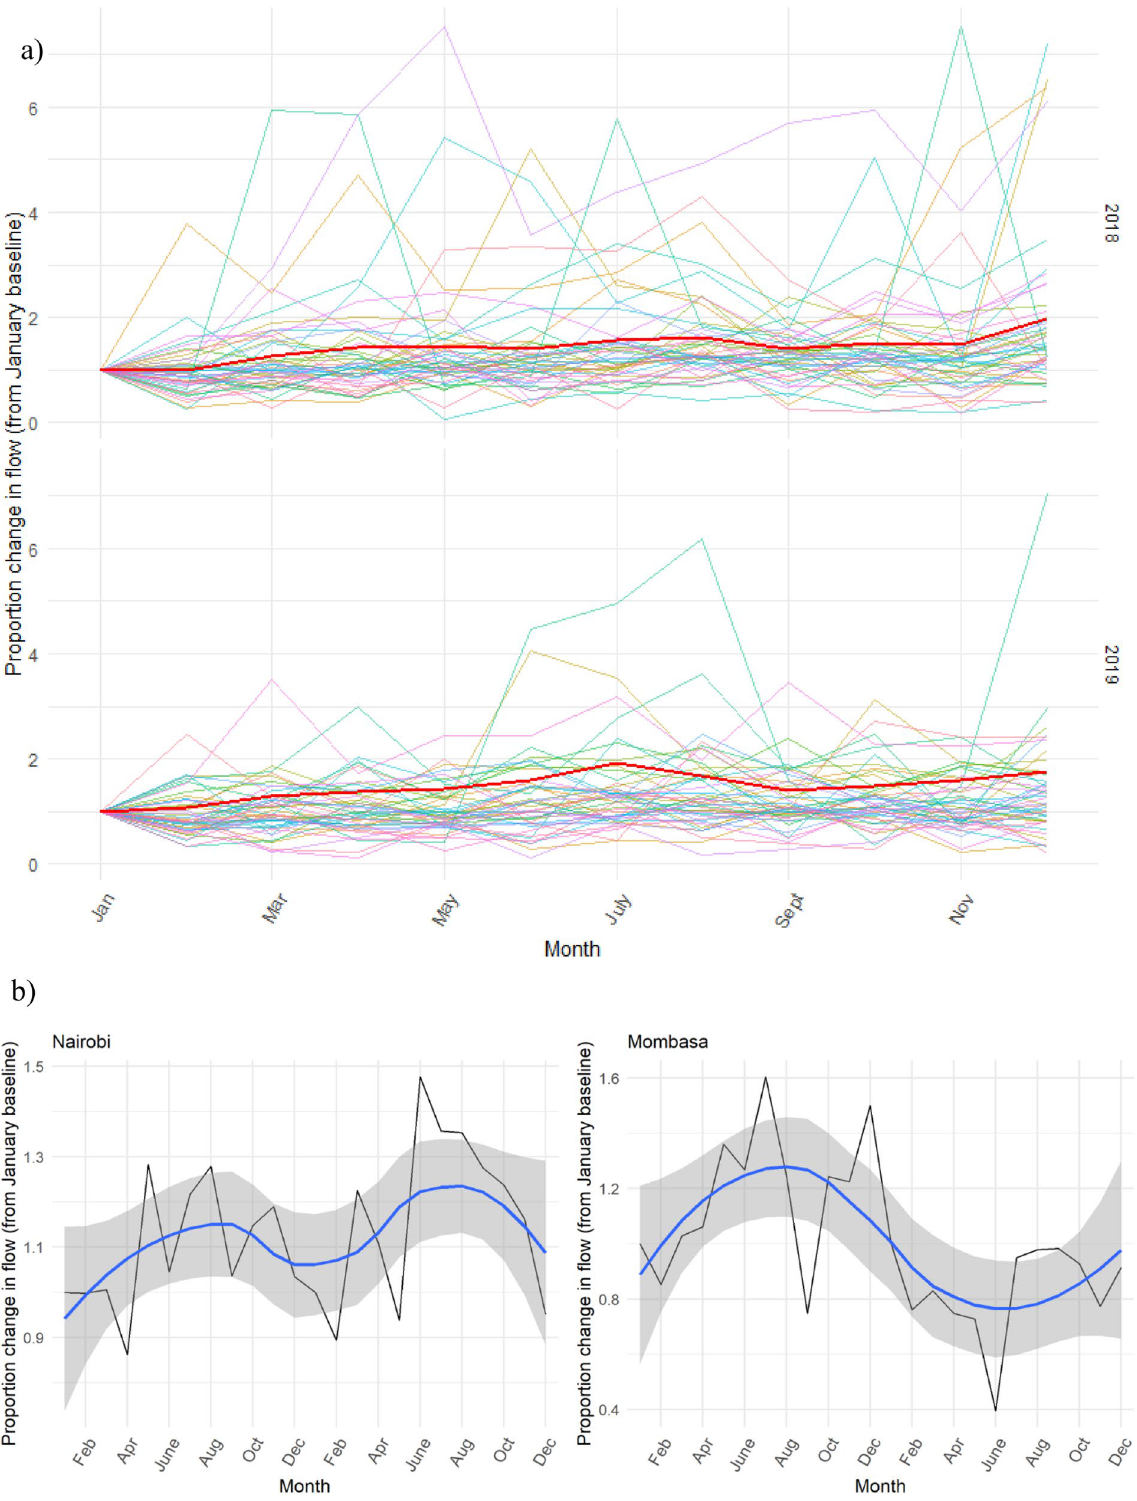
Figure 2. ( a ) Observed change in monthly population flows for 2018 and 2019, as compared to the baseline mobility flow in January of the corresponding year. Coloured lines represent seasonal mobility patterns for each county within Kenya, and the red line represents the average seasonal mobility pattern for all counties over the year. ( b ) Observed mobility patterns (as shown in the top panel) among selected counties, overlaid with smoothed Loess